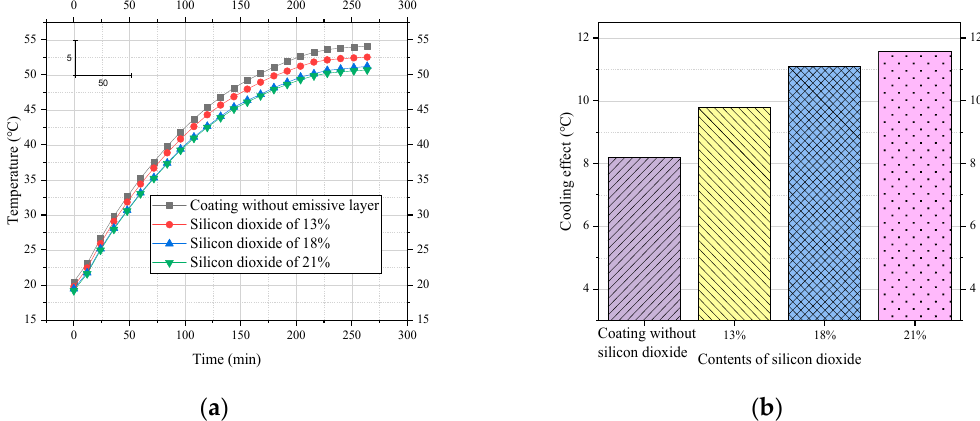
Figure 8. Effect of silicon dioxide on the cooling performance of coatings. ( a ) Process of heating to thermal equilibrium; ( b ) comparison of cooling effects.